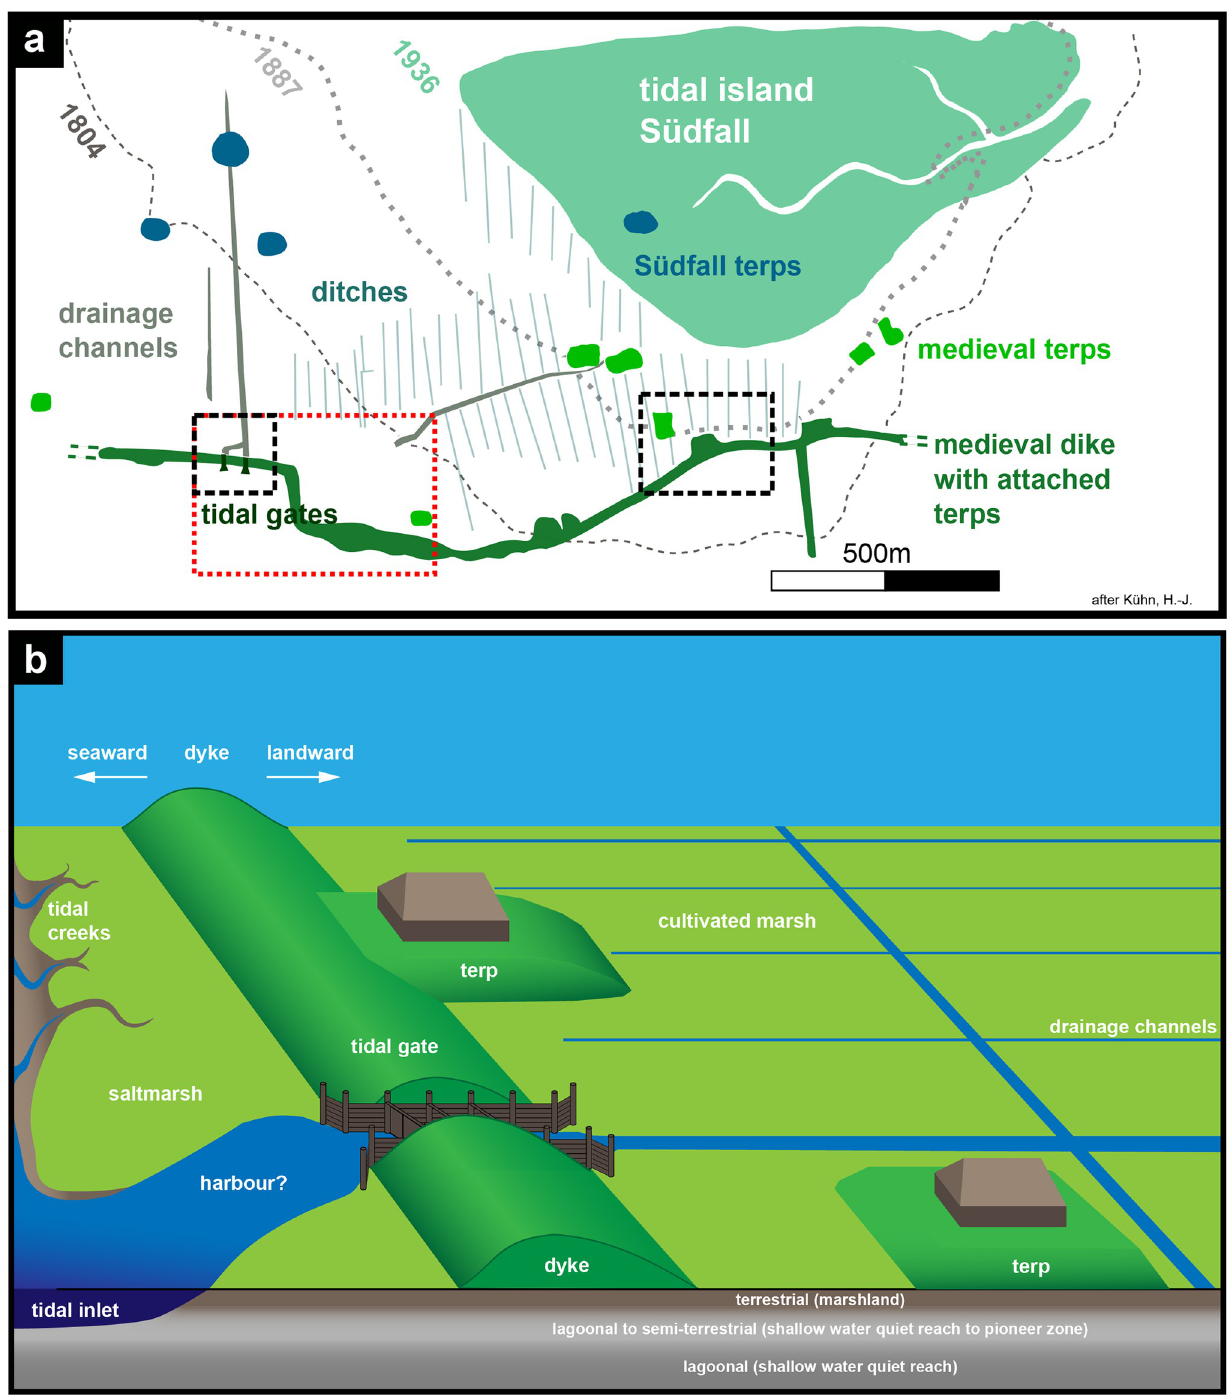
Fig 2. Findings and dyke model. a) map summarizing all significant archaeological structures that were visible in the tidal flats and recorded by a local resident during the early 20th century after [8, 17]. Drawn maps of these sources were georeferenced, combined and redrawn for this figure. Observations were usually located by bearing a fix object on the mainland or the island and triangulation [17]. b) sketch illustrating the main features of the coastal environment connected to the medieval dyke. Typical rectangular dwelling mounds were either attached to the dyke or lay isolated in drained cultivated marshlands and protected the settlements from being flooded. The report by [8] and [9] further shows two tidal gates embedded in the dyke, that opened during low tide to drain the marshes on the landward side but closed with the incoming tide.